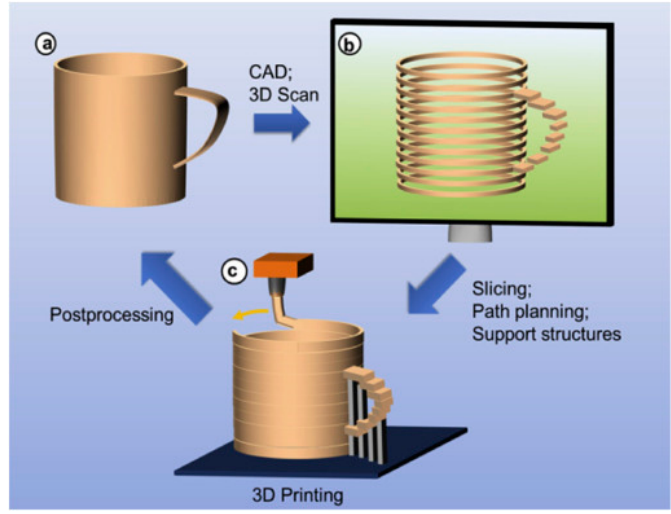
Figure 5. Depicting the route in 3D printing to obtain a physical model from the digital model (adapted with permission from reference [26]).